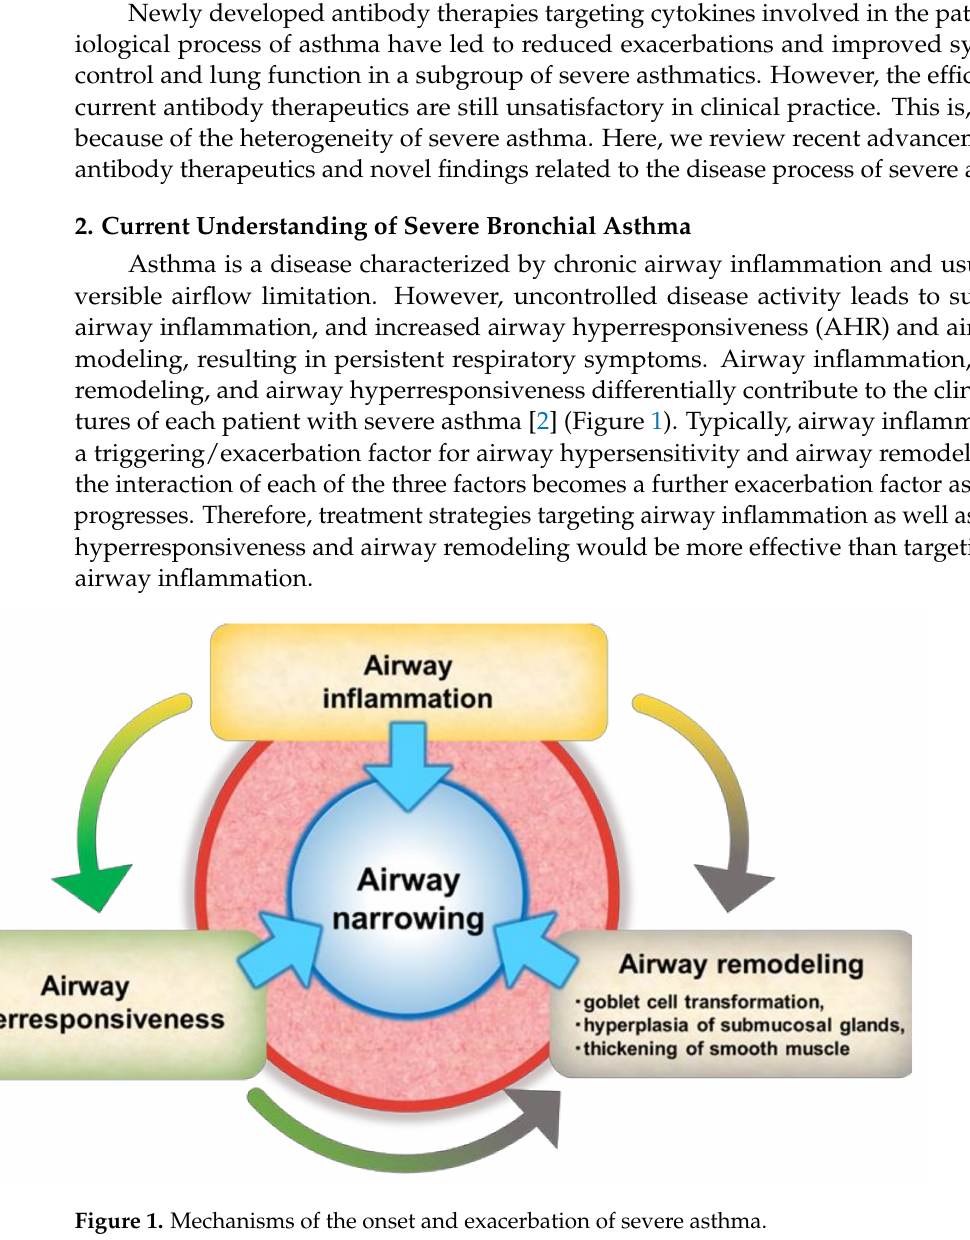
Figure 1. Mechanisms of the onset and exacerbation of severe asthma. Chronic airway inflammation in asthma is typically characterized by eosinophil in- filtration, overproduction of IgE, and Th2 cytokines, including IL-4, IL-5, and IL-13. IL-5, which is essential for eosinophil activation and proliferation and is derived from Th2 cells and Group 2 innate lymphoid cells (ILC2s). IL-4 and IL-13, derived from Th2 cells, promote the production of specific IgE antibodies from B cells. IgE antibodies bind to the IgE receptor (Fc ε RI) on the surface of mast cells and prepare them for activation during allergen exposure. IL-13, secreted from Th2 cells and ILC2s, shares the IL-4 receptor and induces smooth muscle hyperplasia, goblet cell hyperplasia, and mucous secretion, leading to airway remodeling and decreased respiratory function. Lung ILC2s respond to the alarmin IL-33, or IL-25 and TSLP released by epithelial cells, which induce their activation and the production of large amounts of IL-5 and IL-13. Thus, IgE, IL-5, and IL-4/IL-13 are particularly important in the pathogenesis of type 2 asthma. Blood eosinophils have been proposed as a surrogate marker of airway eosinophilia [3]. Elevated numbers of blood eosinophils have been associated with more severe asthma and have shown to predict